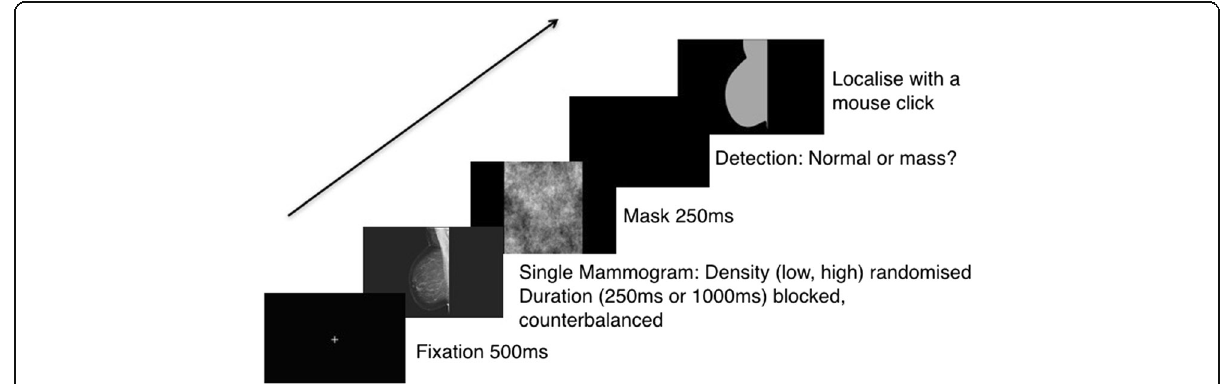
Fig. 2 Example trial for 12 radiologists who were asked first whether the image was normal or contained a mass, and then to use the mouse to indicate the location of the mass if